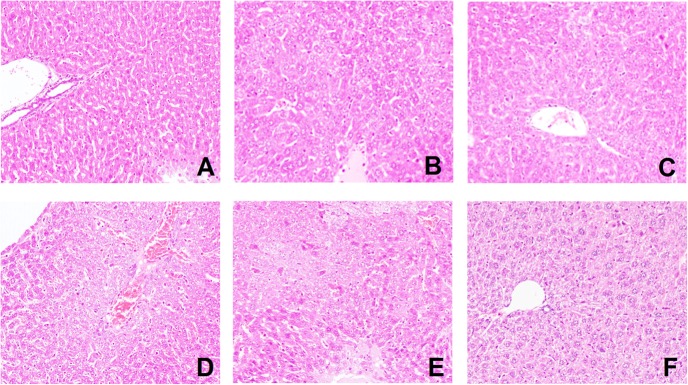
Effect of emodin on liver morphology. (A–F) Pathological changes were observed in the liver tissues with H&E staining (original magnification×100). The (A) emodin (80 mg/kg) group, (B) emodin (40 mg/kg) group, (C) emodin (20 mg/kg) group, (D) DEX group, (E) model group, and (F) normal group. In the liver, interstitial cells showed obvious edema. (A–C) Liver tissues from mice treated with different concentrations of emodin groups looked healthier compared with those from model mice infected with LPS.